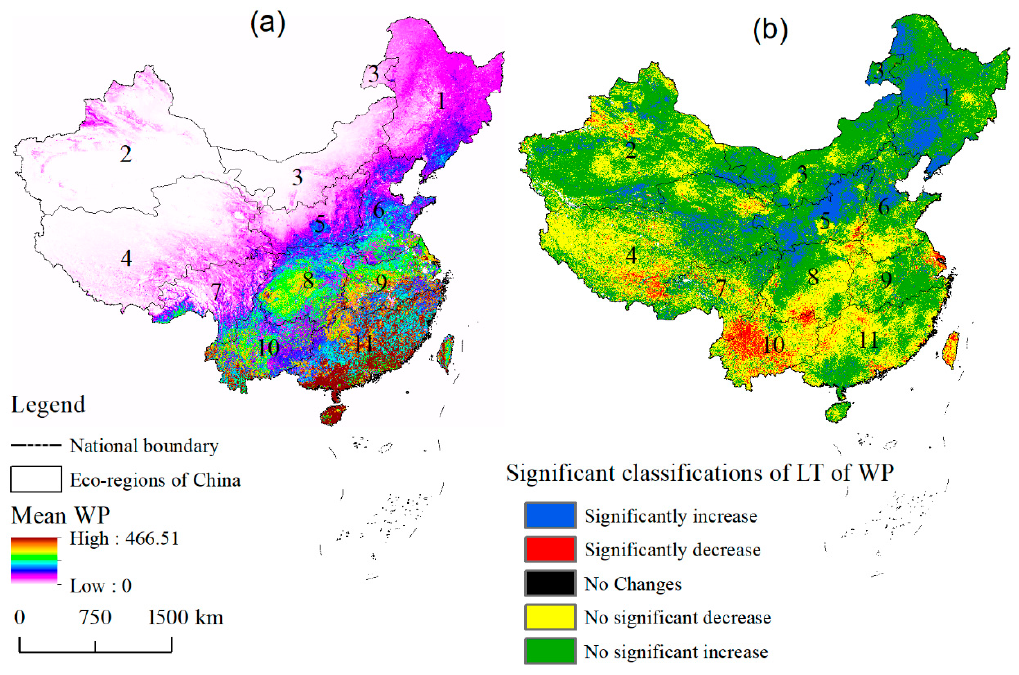
Figure 3. Spatial patterns of mean annual WP ( a ) and the linear trend of annual WP ( b ) from 2000 to 2013. In Figure 3b, the classification method of the linear trend is given in Section 2.3.